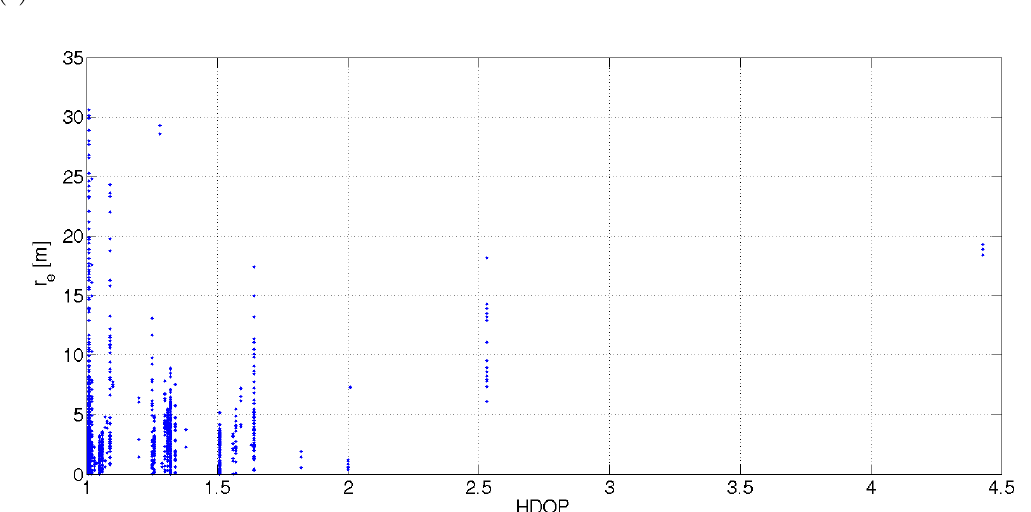
Figure 3. The relation between the values of the HDOP parameter and the distance errors r ( t ) e